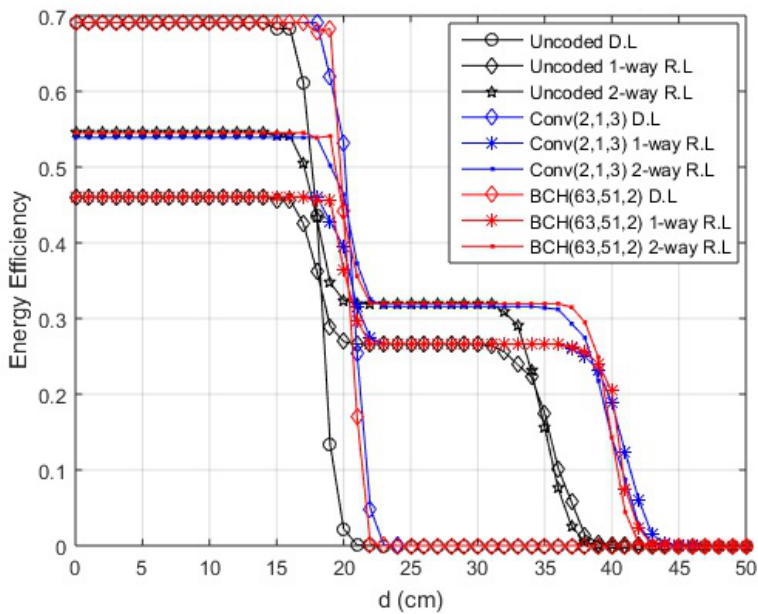
Figure 14. Energy efficiency for joint network channel (JNC) coded data, convolutional R = 1/2, BCH t = 2 (in-body communication).